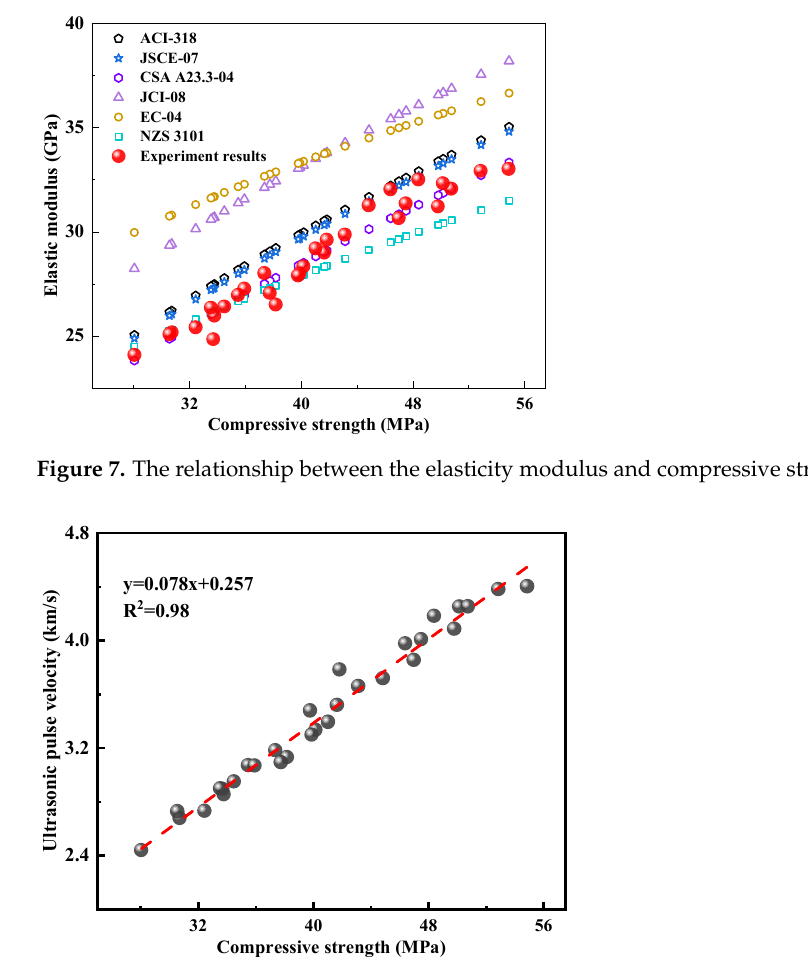
Figure 8. The relationship between the ultrasonic pulse velocity and compressive strength.